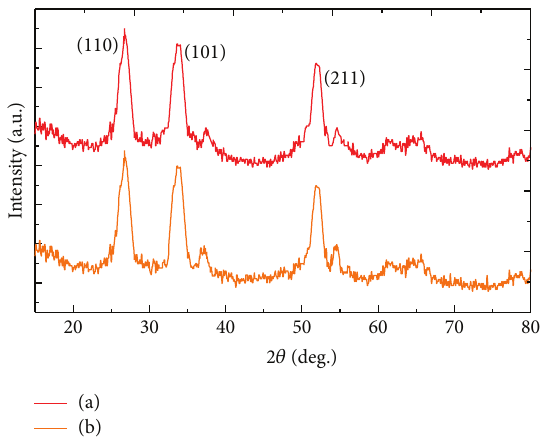
Figure3:TypicalXRDpatternsof(a)pureand(b)Sm 2 O 3 decorated SnO 2 nanostructures.